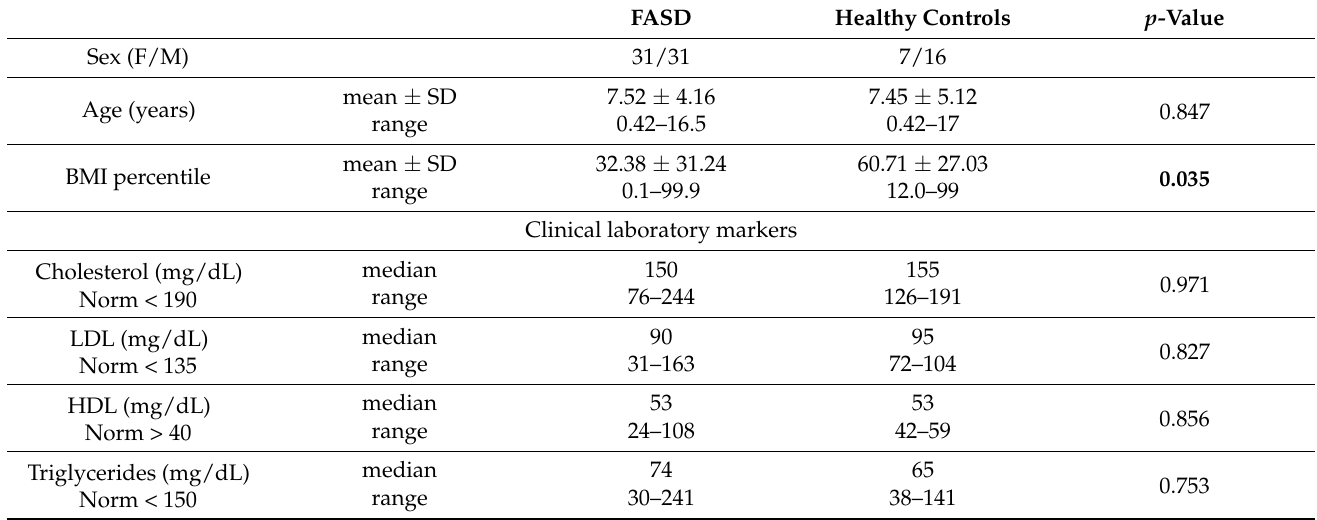
Table 1. Baseline demographic and clinical data of the study